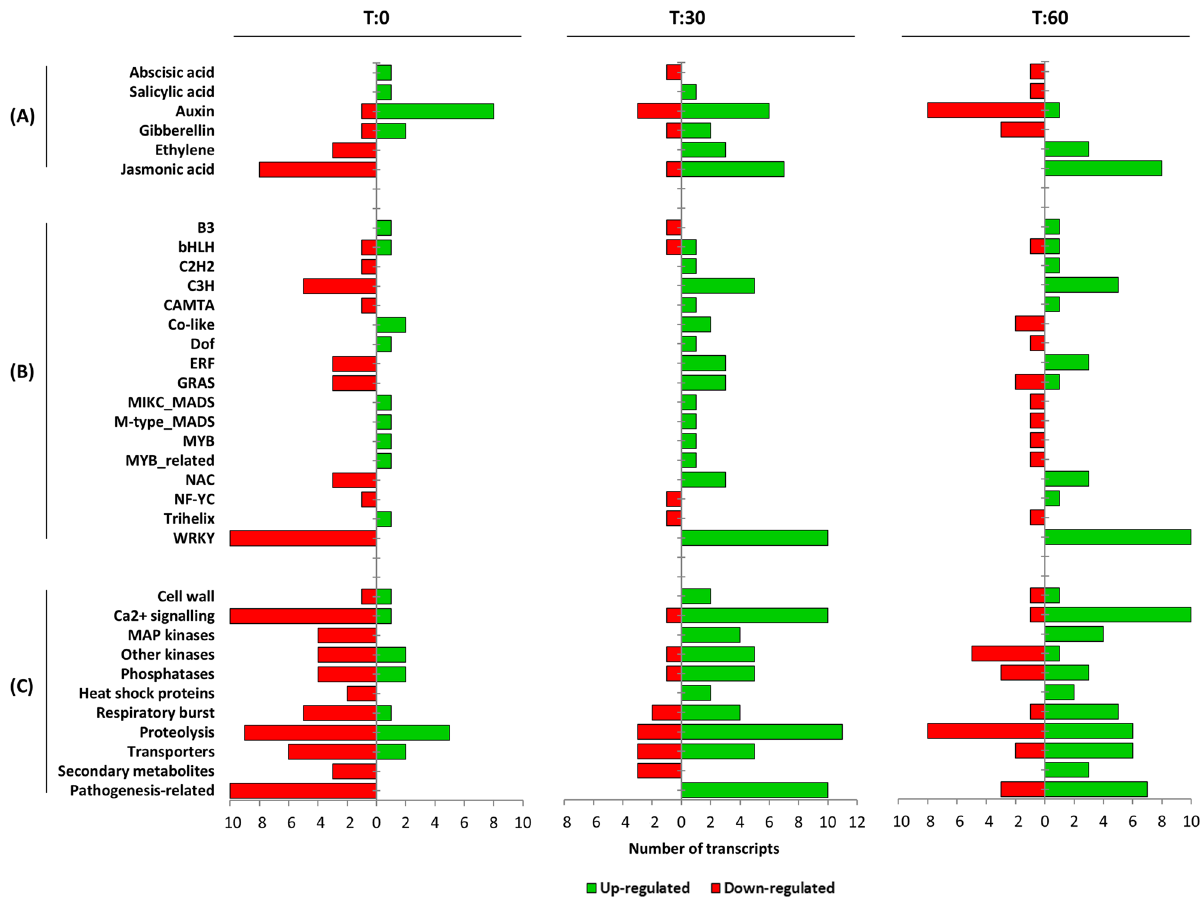
Figure 6. The number of DEGs either up-regulated (green) or down-regulated (red) in wound-responsive processes relating to ( A ) phytohormones, ( B ) transcription factors and ( C ) other significant processes in D. cymosum